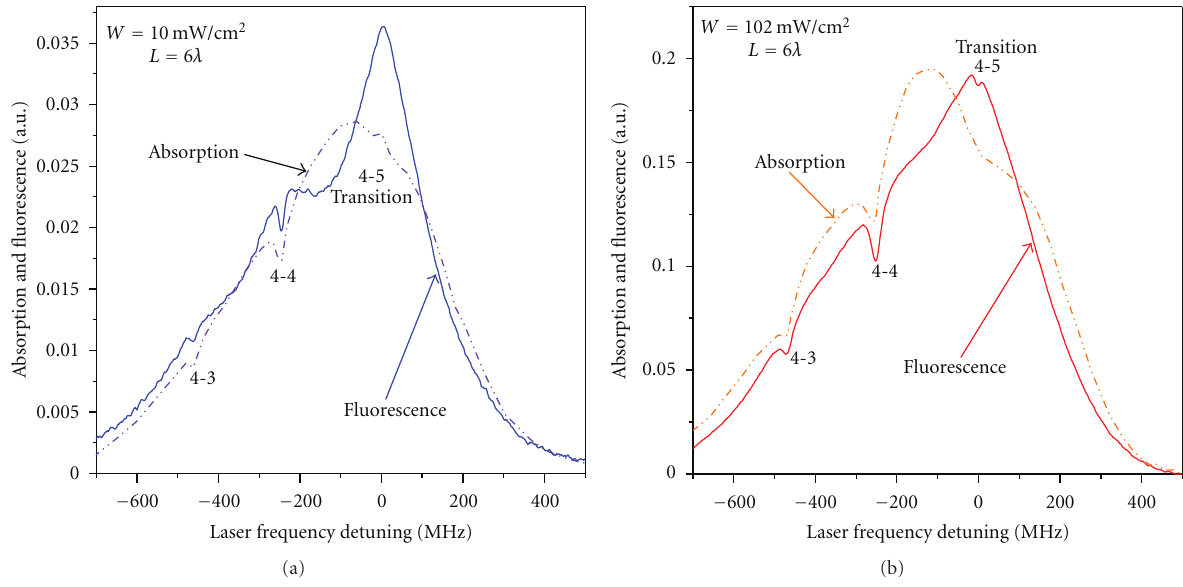
Figure 12: Sign reversal of the velocity selective optical pumping resonance with light intensity, observed for the F g = 4 → F e = 5 transition, in L = 6 λ cell ( λ = 852nm). Atomic source temperature T = 49 ◦ C. Light intensity: W = 10 mW/cm 2 (a) and W = 102 mW/cm 2